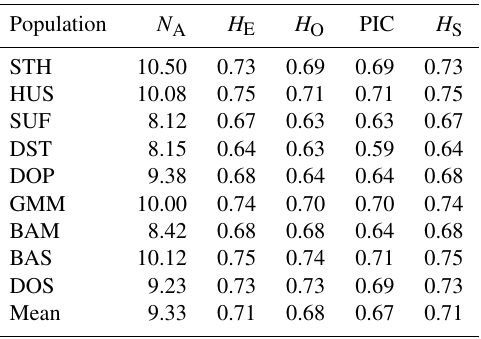
Table 3. Genetic diversity information in the nine sheep popula- tions.